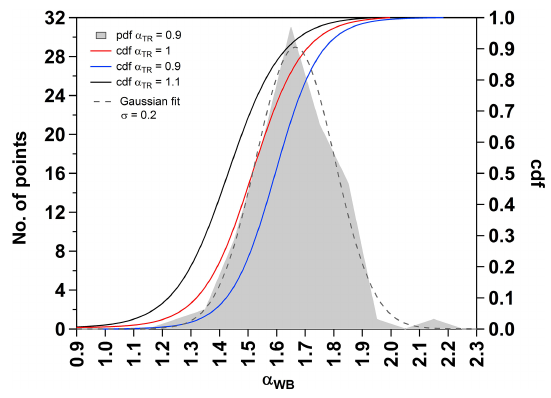
Figure 4. Histogram (pdf) and cumulative probability density func- tion (cdf) of α WB if α WB is calculated for every data point, assum- ing a fixed α TR (0.9, 1.0, or 1.1) and using b abs , 470 , b abs , 950 , and MAC TR / MAC WB = 1.